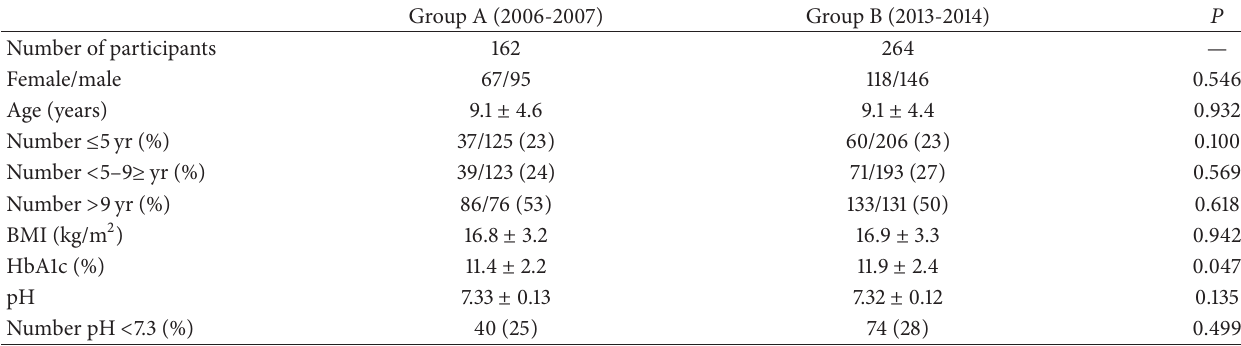
Table 1: Comparison between children with newly diagnosed T1D in 2006-2007 (group A) and 2013-2014 (group